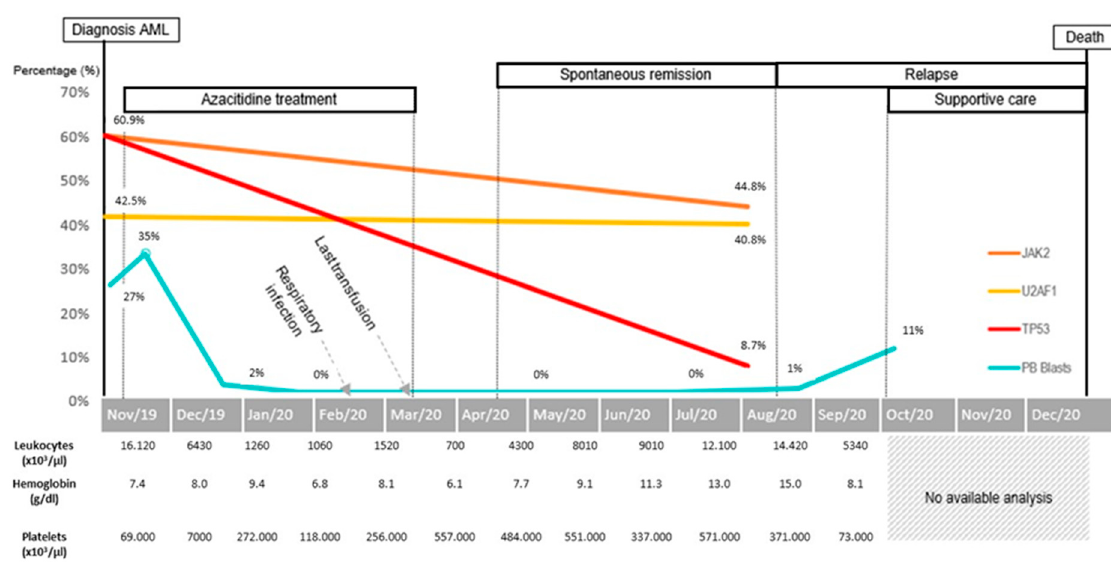
Figure 1. Timeline of complete blood count, peripheral blast count and molecular alterations detected in bone